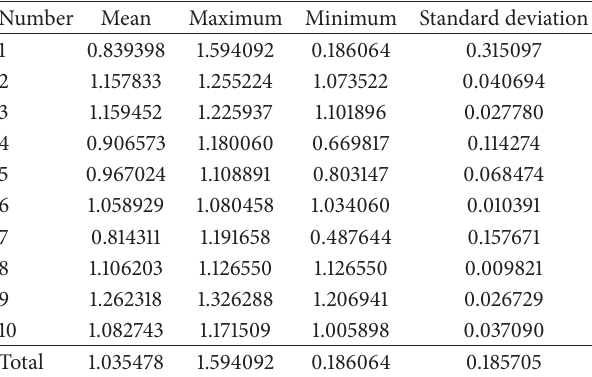
Table 5: The descriptive statistics of time-varying beta of small corporations.